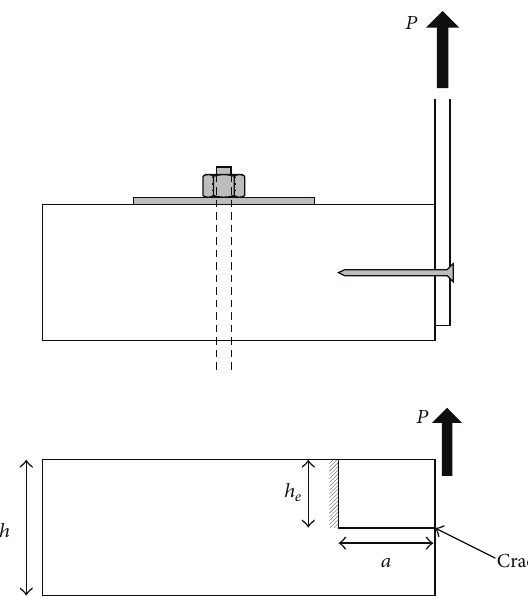
Figure 5: Geometry, boundary conditions, and loading conditions used in Caprolu et al. [18] for a horizontal crack.